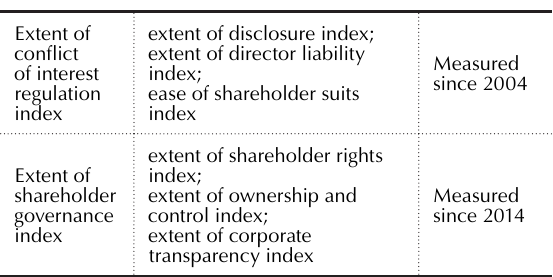
Table 2. Investor Protection